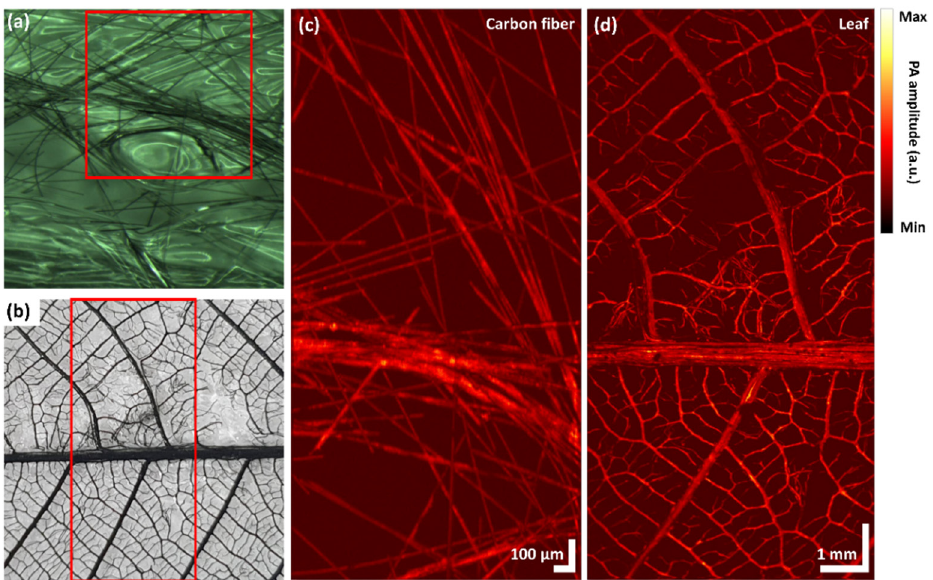
Figure 3. Photographs and PA MAP images of carbon fiber networks and a leaf skeleton target. ( a ) Magnified photograph of carbon fiber networks. ( b ) Magnified photograph of leaf skeleton target. ( c , d ) PA MAP images of the region in ( a , b ), respectively. MAP, maximum amplitude projection.